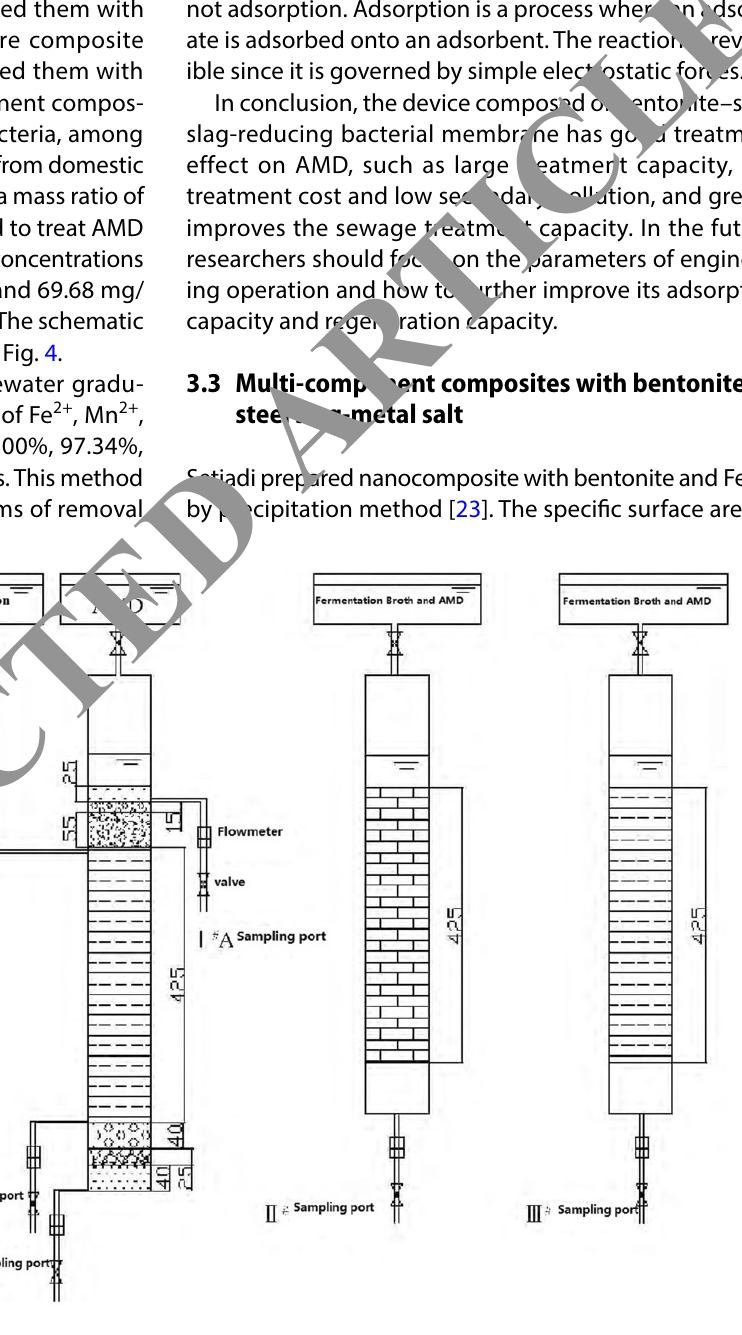
Fig. 4 Schematic diagram of dynamic test